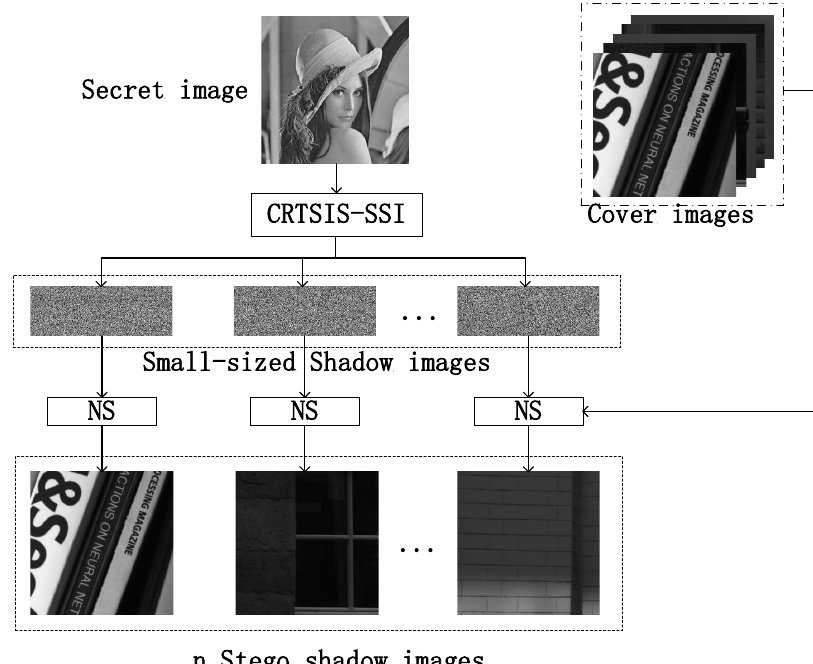
Figure 2. The sharing model of the proposed scheme